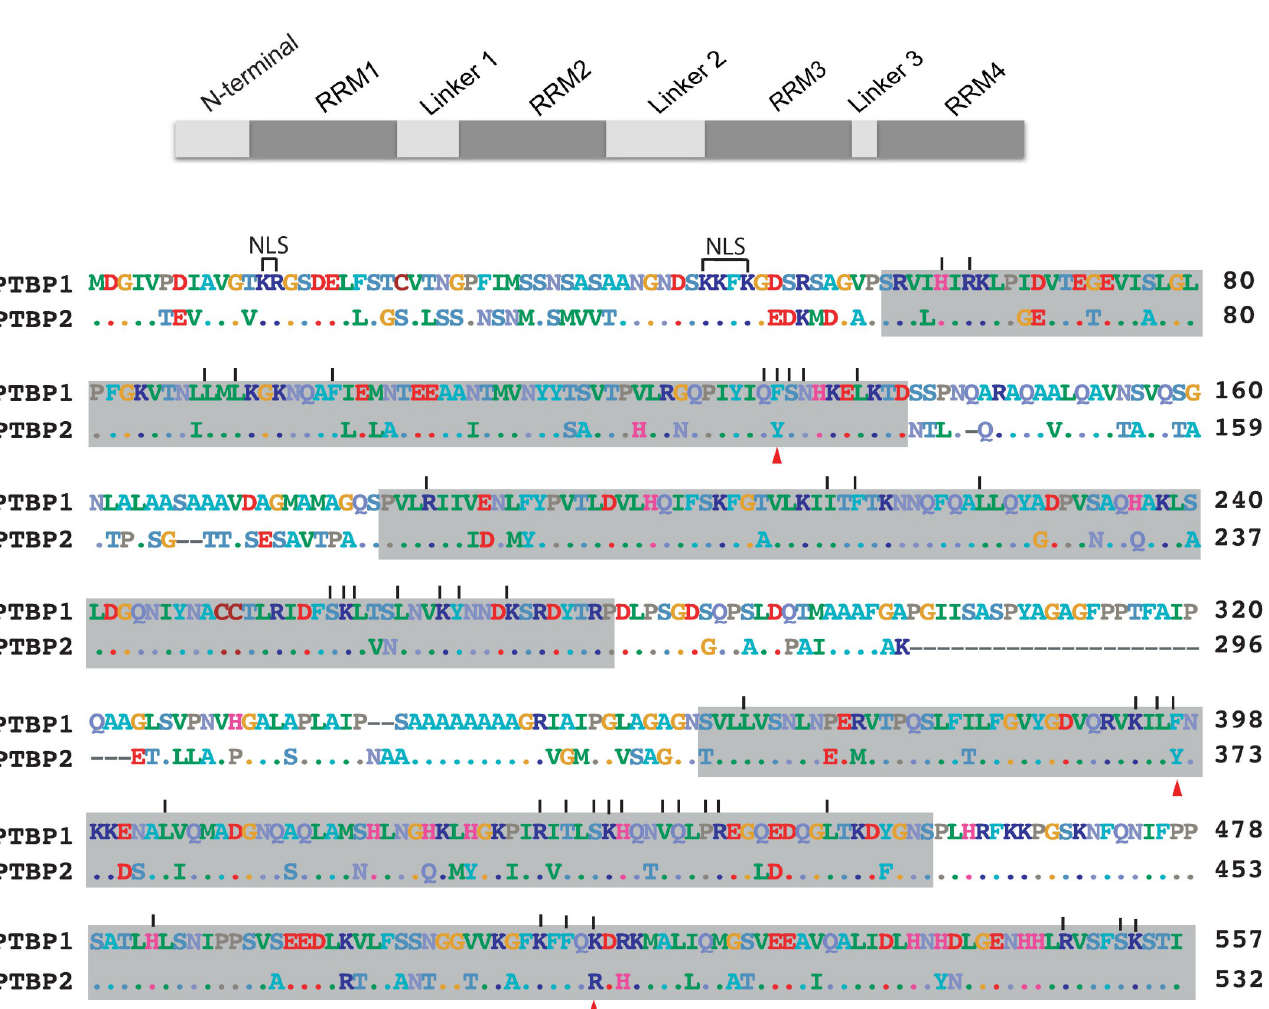
Fig 1. PTBP domain organization and amino acid sequence alignment. (top) A schematic representation of PTB protein indicating each distinct region. (bottom) Amino acid sequence alignment of human PTBP1 (isoform 4) and PTBP2. Gray boxes indicate RNA binding domains. Lines above the sequence indicate RNA interacting residues. Red triangles below the sequence indicate RNA interacting residues that are conservative substitutions in PTBP2. Gaps are indicated as dashes (-) in the alignment.